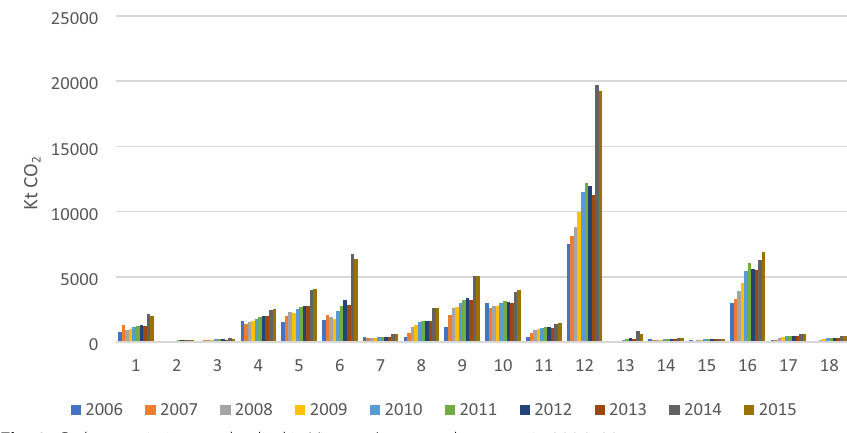
Fig. 2 Carbon emissions embodied in Vietnam’s exports by sector in 2006–2015